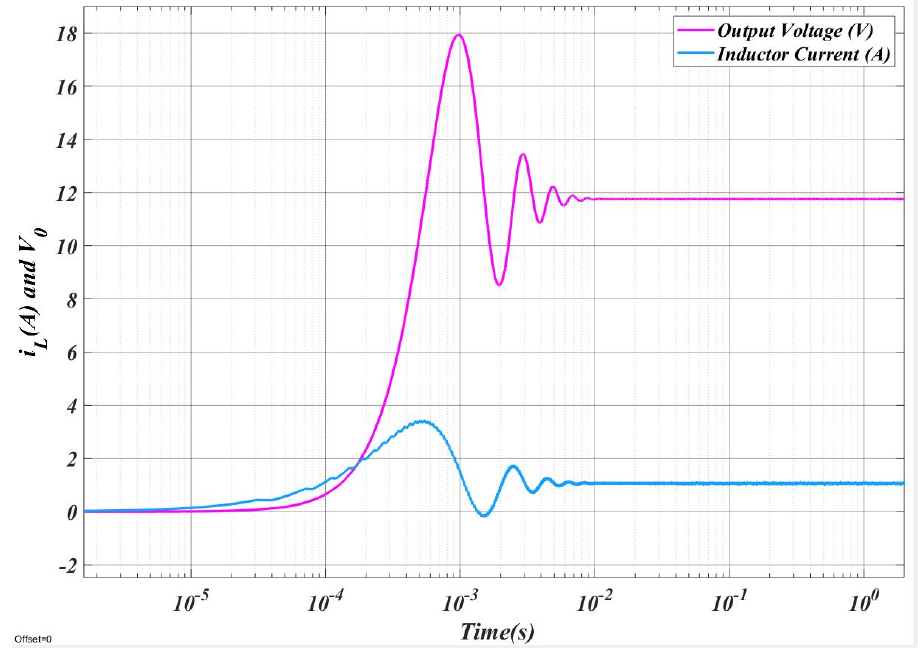
Figure 5. i L and V 0 Vs .